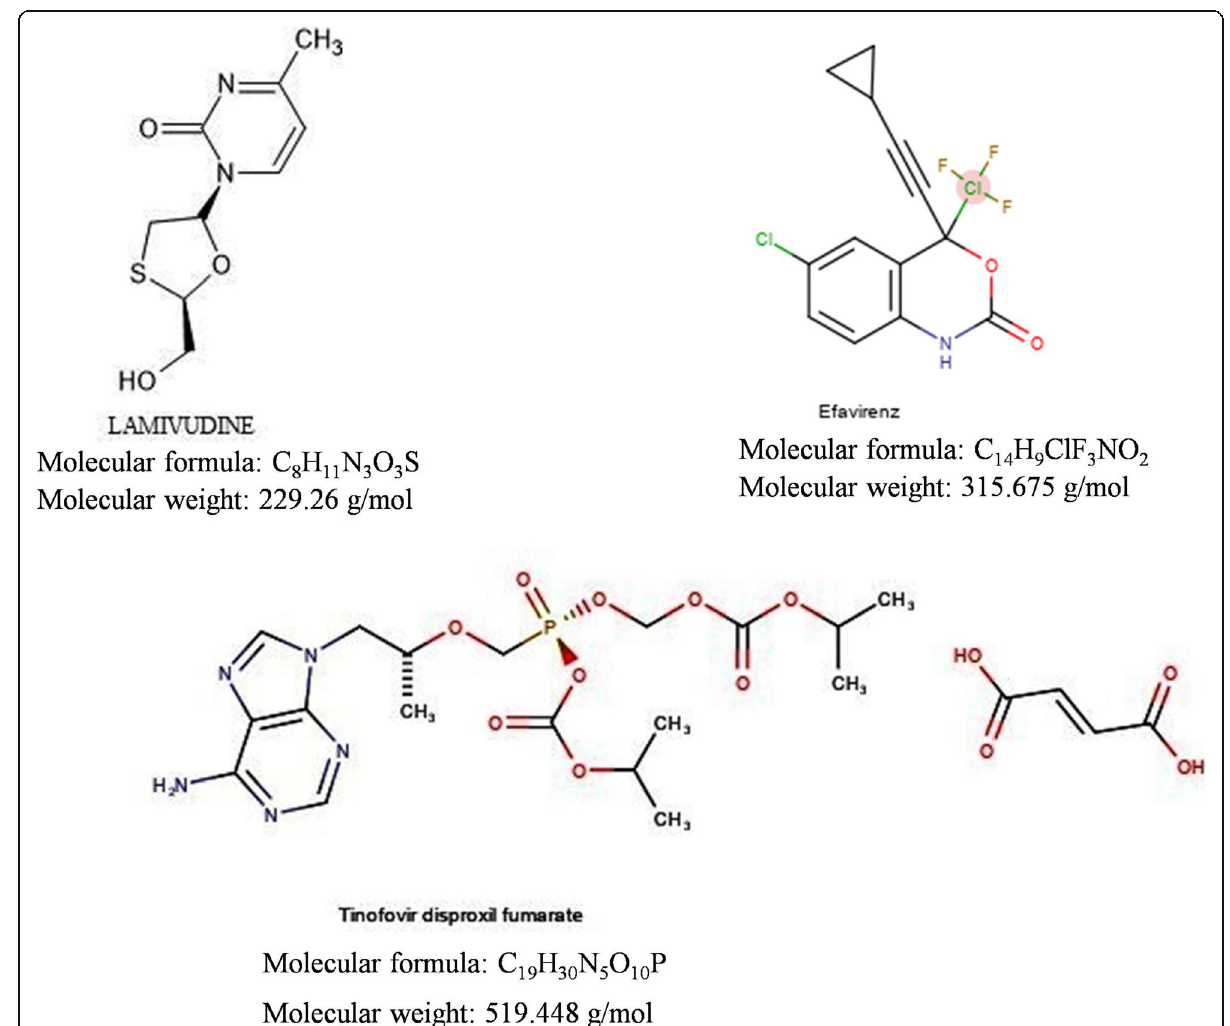
Fig. 1 Chemical structures of LAM, EVZ, and